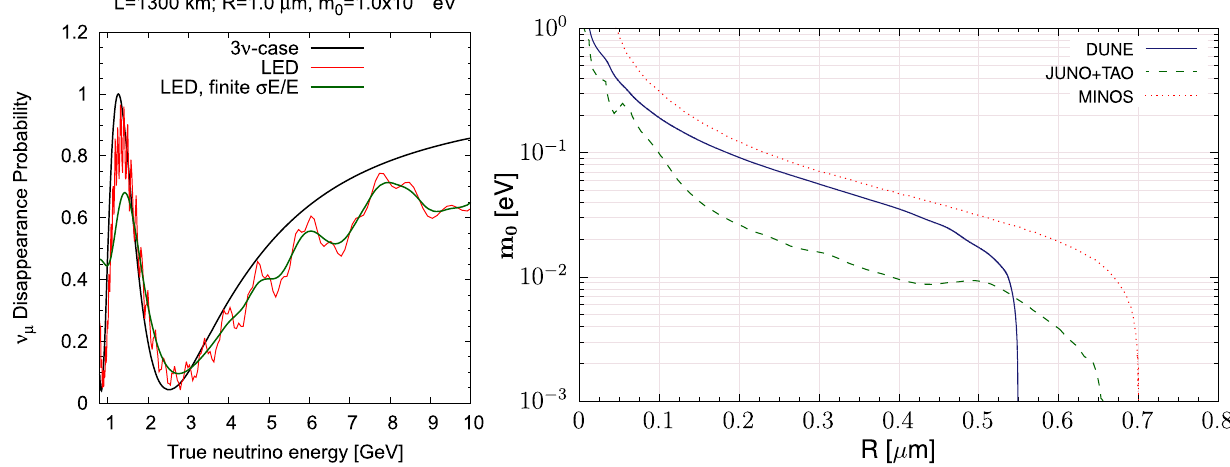
Fig. 1 Left:LEDimpactontheoscillationprobabilities.LED-induced muon neutrino disappearance probability (red and green lines) in com- parison to the three-neutrino flavor case (3 ν -case, black line), as the function of neutrino energy with 1300 km baseline. The LED-induced oscillations without (with) the detector energy resolution are shown by the red (green) line. Particular values of m 0 and R were chosen to enhance the LED effect, and the standard oscillation parameters were fixed to their best fit values from Ref. [79]. Right: Future sensitivities to